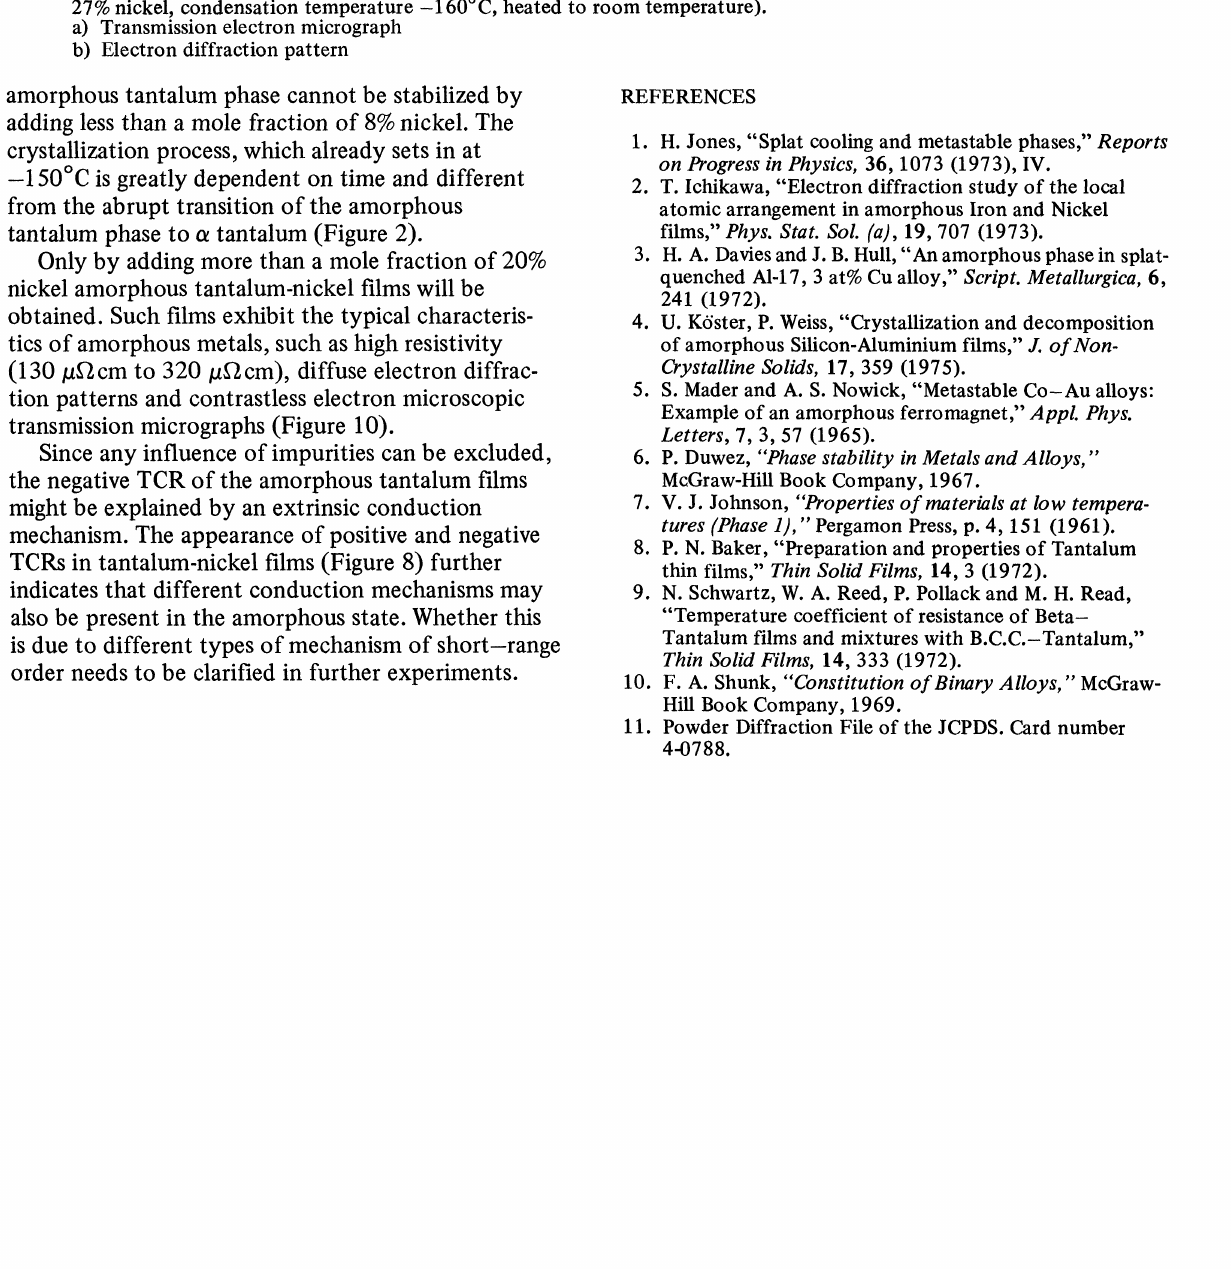
FIGURE 10 Transmission electron micrograph and diffraction pattern of a tantalum-nickel film (mole fraction of 27% nickel, condensation temperature -160C, heated to room temperature). a) Transmission electron micrograph b) Electron diffraction